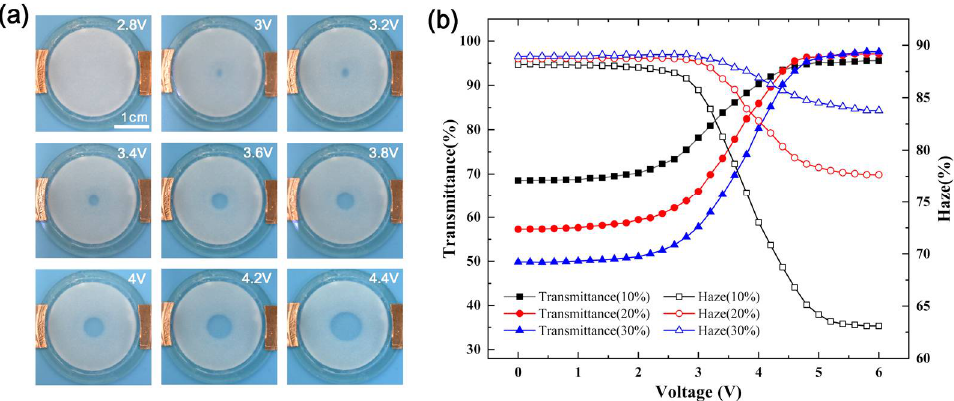
Figure 4. ( a ) Pictures of films with melting centers. ( b ) Transmittance and haze of paraffin-PDMS films with different concentrations changed with voltage.